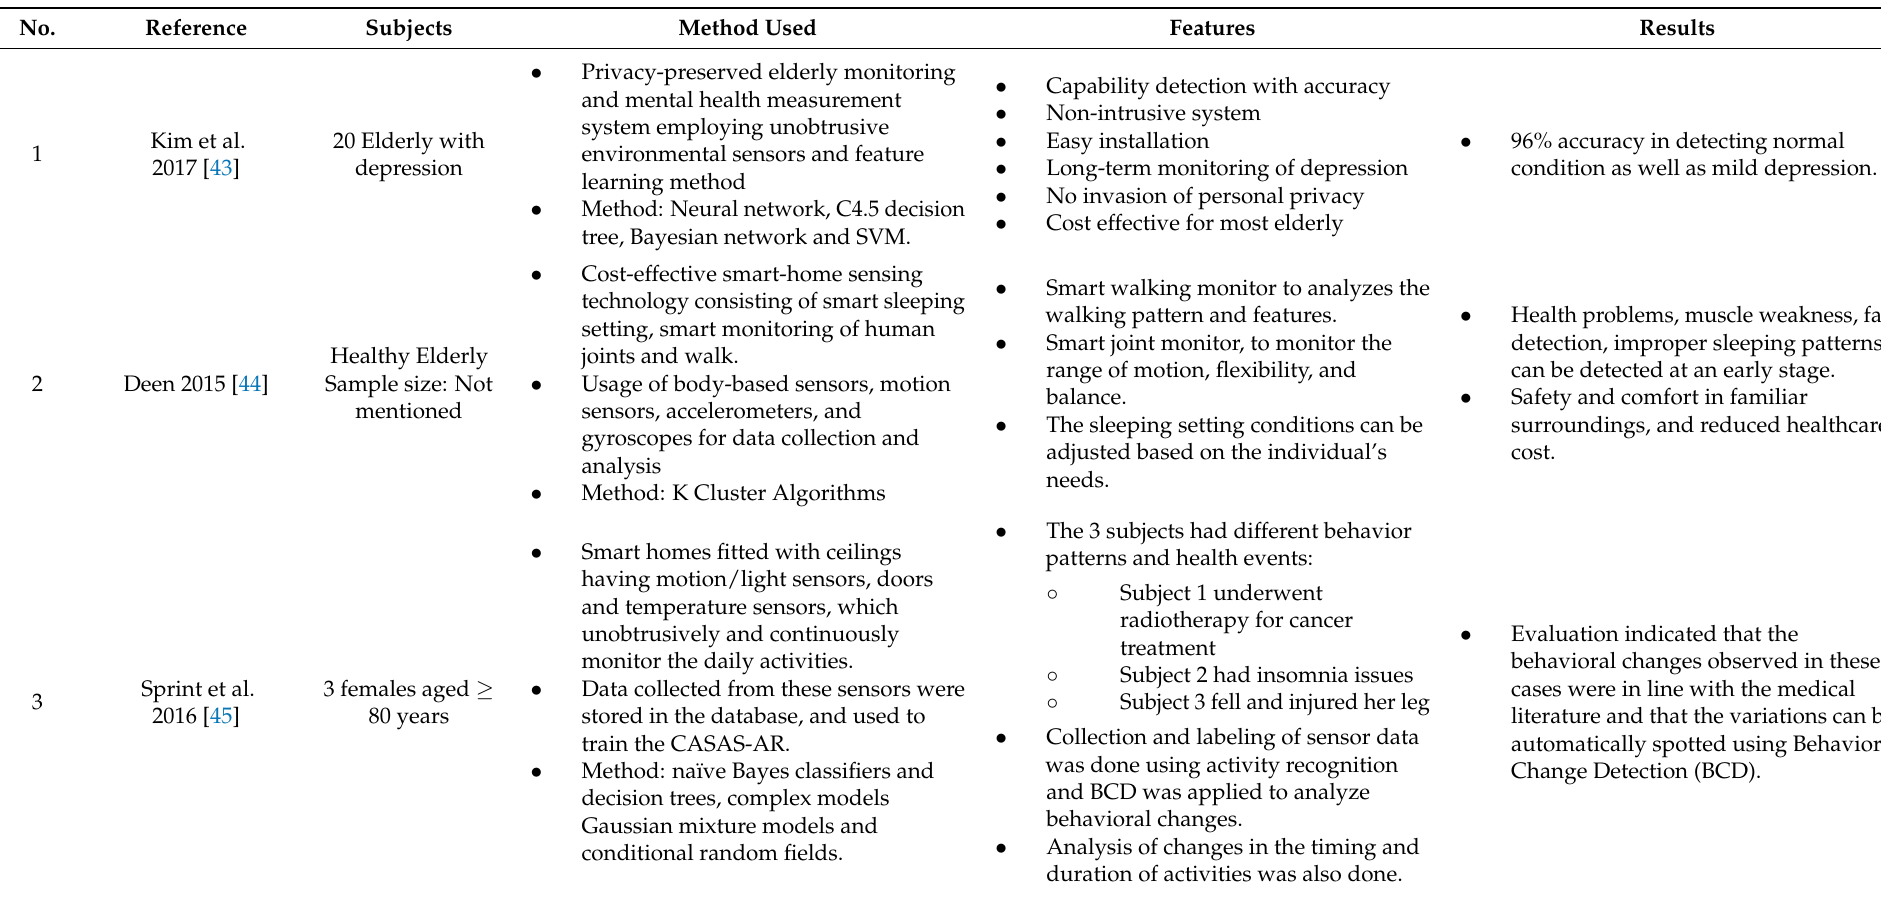
Table 1. Summary of the studies included in the